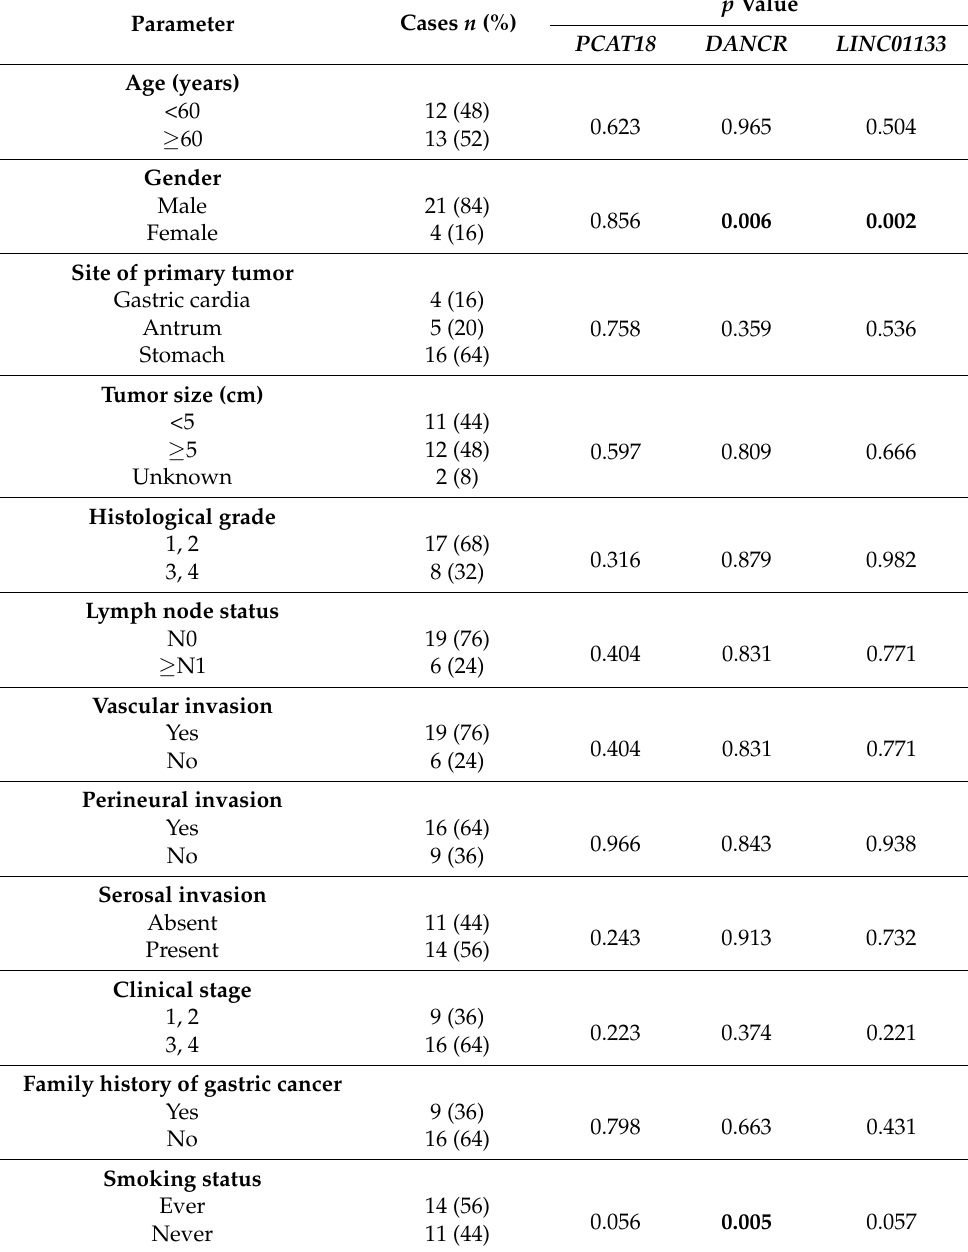
Table 2. Associations of clinical and histopathological tumor parameters with PCAT18 , DANCR , and LINC01133 expression